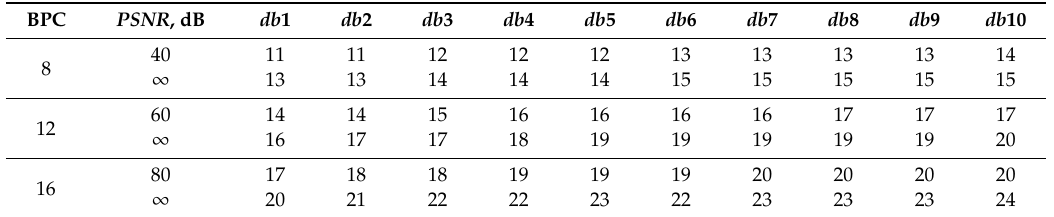
Table 10. Minimum values of r , at which the result of 3D medical images DWT with Daubechies wavelets reaches high and maximum quality.